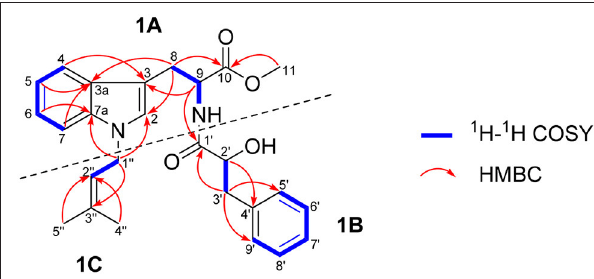
FIGURE 2 | Key 1 H- 1 H COSY and HMBC correlations of 1